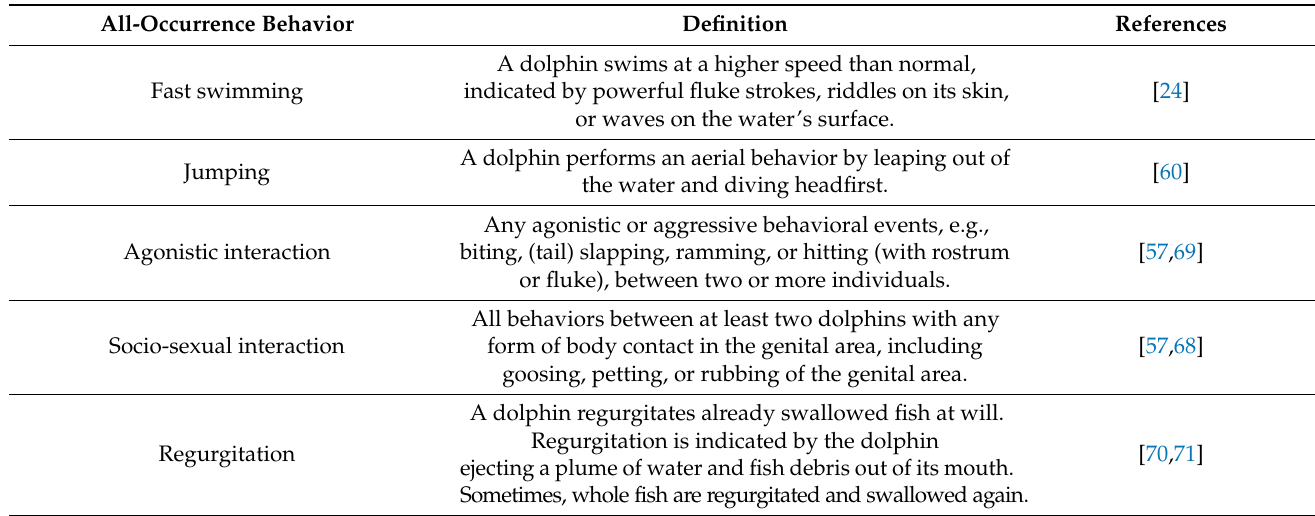
Table 3. All-occurrence behaviors, sampled during each